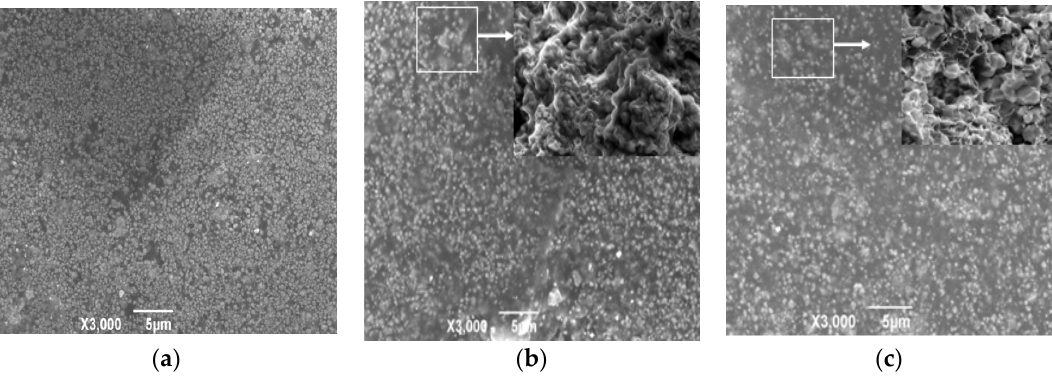
Figure 2. SEM (Scanning Electron Microscopy) of PZT ‐ poly (vinylidene fluoride) (PVDF) composites. ( a ) Unmodified; ( b ) 1% KH ‐ 570; ( c ) 1% NDZ ‐ 101.